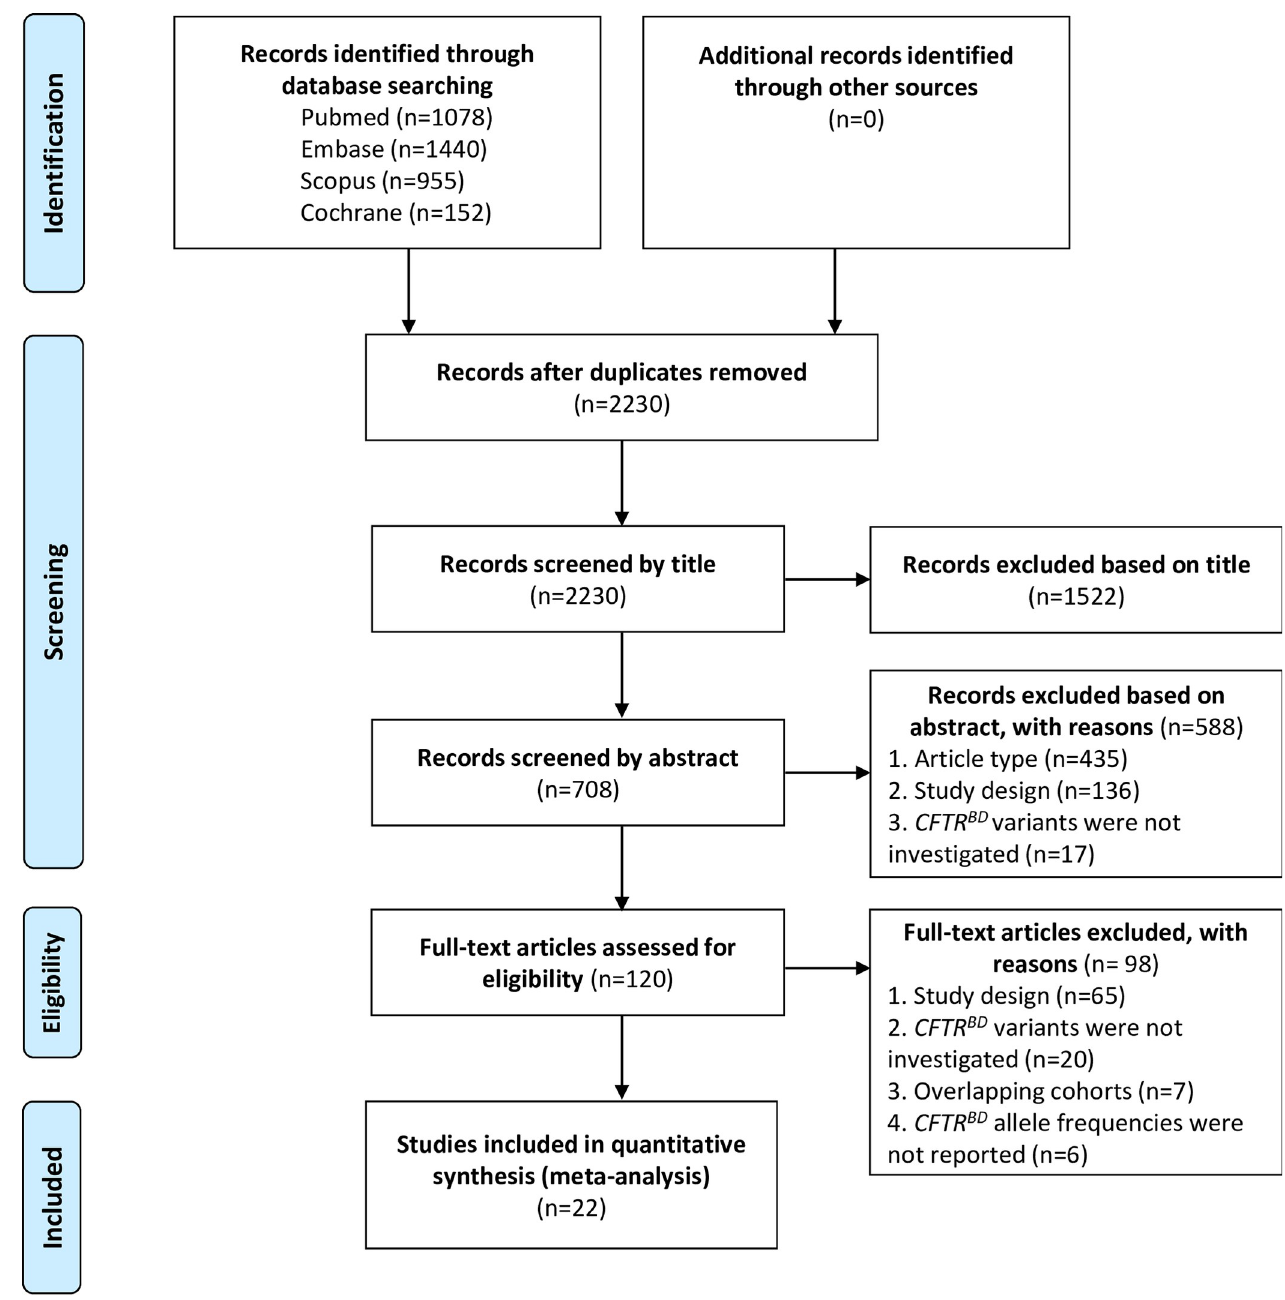
Fig 1. PRISMA flow diagram showing the systematic search and selection